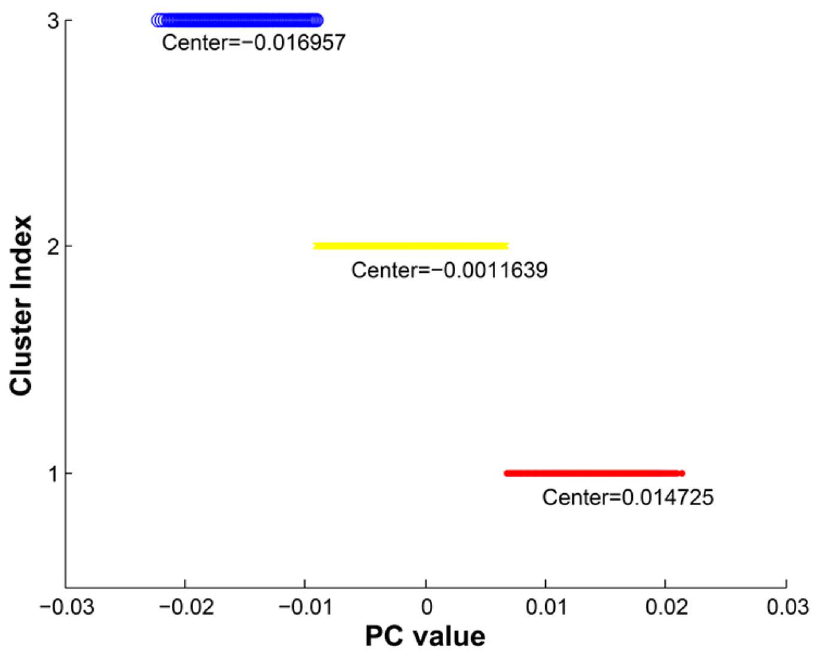
Fig. 2. Cluster analyses using K-means clustering with squared Euclidean distance measurement. PC value is a numerical value obtained from STRUCTURE PC1 vector for each individual. In this approach the algorithm attempts to find the centers of the clusters in order to minimize the sum of the distances within each cluster.